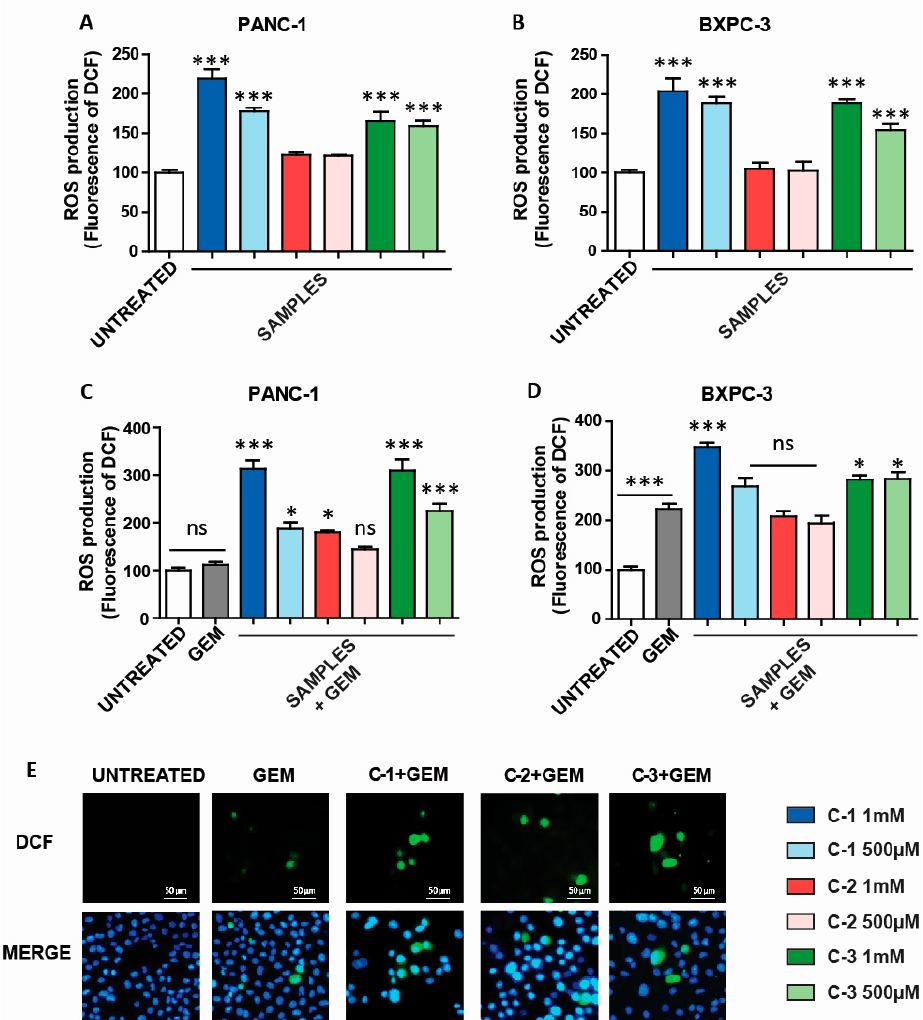
Figure 4. Reactive oxygen species (ROS) generated by coordination complexes. ( A , B ) ROS generation in pancreas cancer cell lines incubated with C ‐ 1, C ‐ 2 , and C ‐ 3 for 48 h. The DCF fluorescence (ROS production) of treated cells was normalized to untreated controls and reported as mean ± SEM. ( C , D ) ROS generation after combination therapy (incubation with GEM (4.5 μ M) and C ‐ 1, C ‐ 2 , and C ‐ 3 for 48 h). The DCF fluorescence of treated cells was normalized to that of untreated controls and reported as mean ± SEM. Statistical analysis was performed using one ‐ way ANOVA (each group vs. control). (*** p < 0.001, * p < 0.05). ( E ) Fluorescence images of PANC ‐ 1 cells untreated and treated with the combined therapy. DCF, corresponding to ROS production levels are shown in green, and the nuclei are labeled in blue by Hoechst staining.